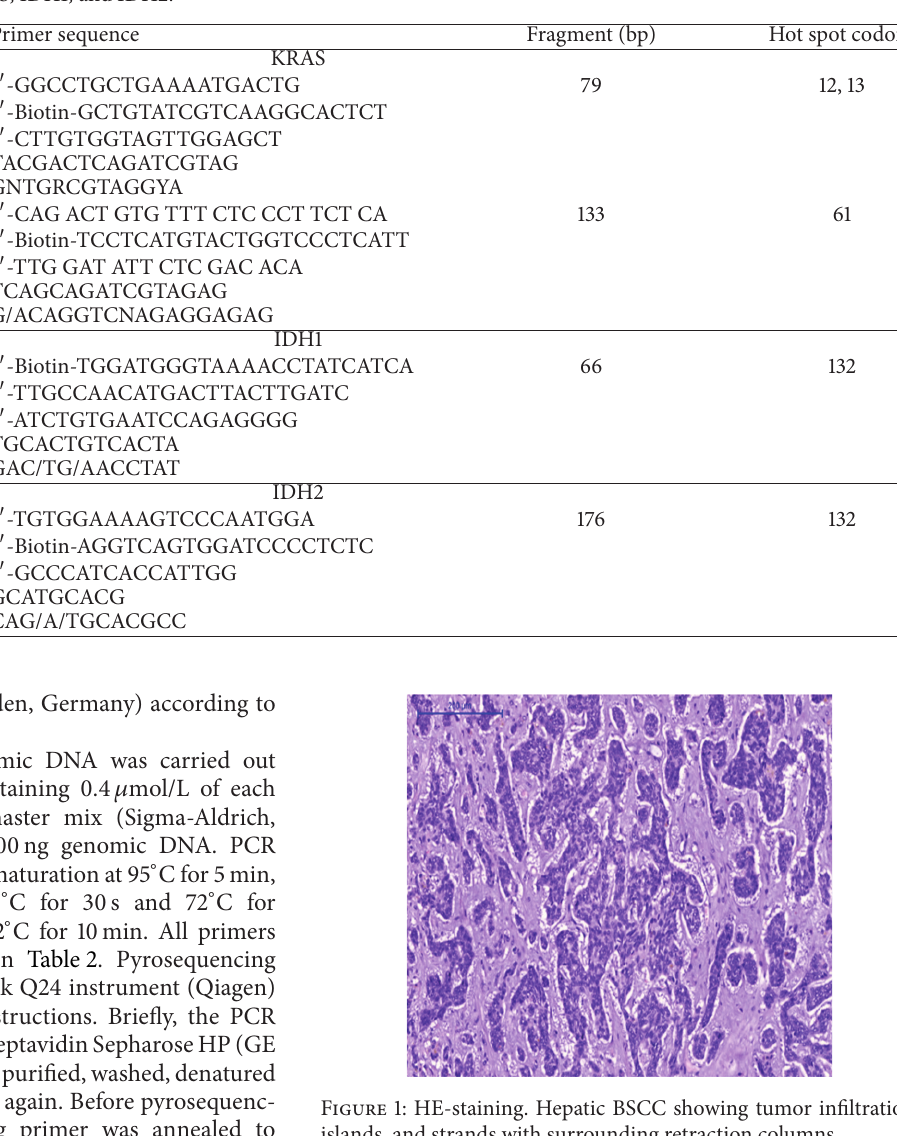
Table 2: Primer sequences (For., Rev., Seq.), amplified fragment sizes, and pyrosequencing dispensation and analysis orders (Disp. and Anal.) used for mutational analysis of KRAS, IDH1, and IDH2.